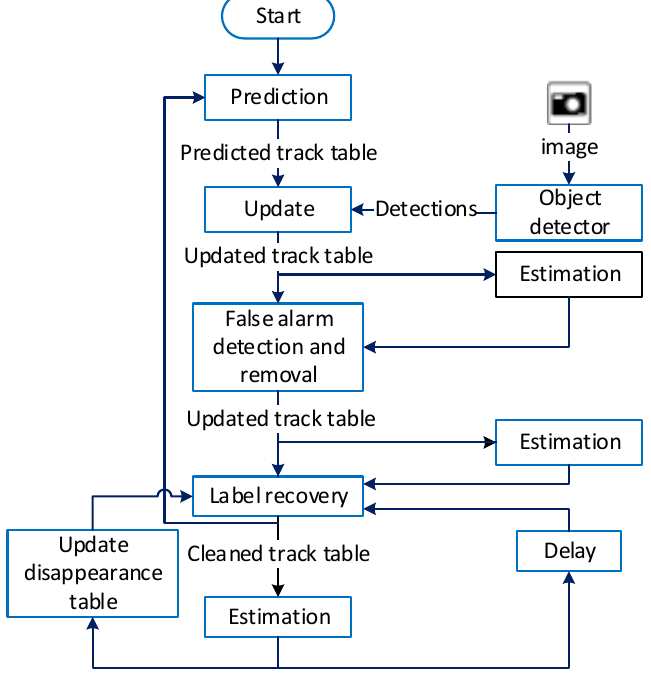
Figure 2. An overview of the proposed solution and its major